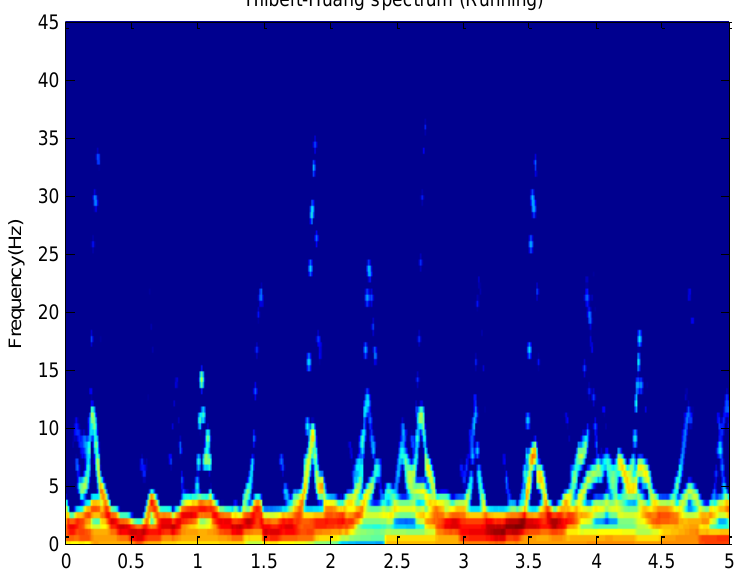
Figure 3. The Hilbert-Huang spectrum for the running data with 100 Hz frequency. The activity energy appears in skeleton lines representing each intrinsic mode function (IMF). The Hilbert-Huang spectrum was filtered by a 9 × 9 weighted Gaussian